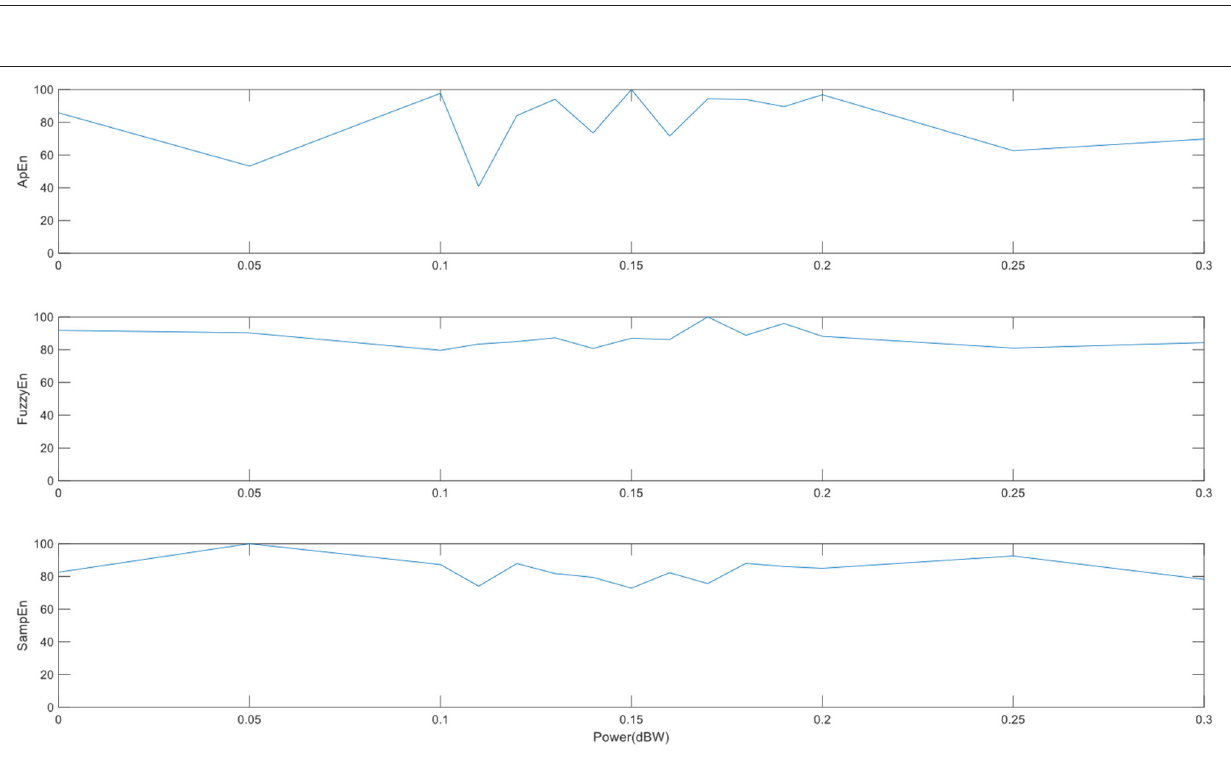
Frontiers in Psychiatry |